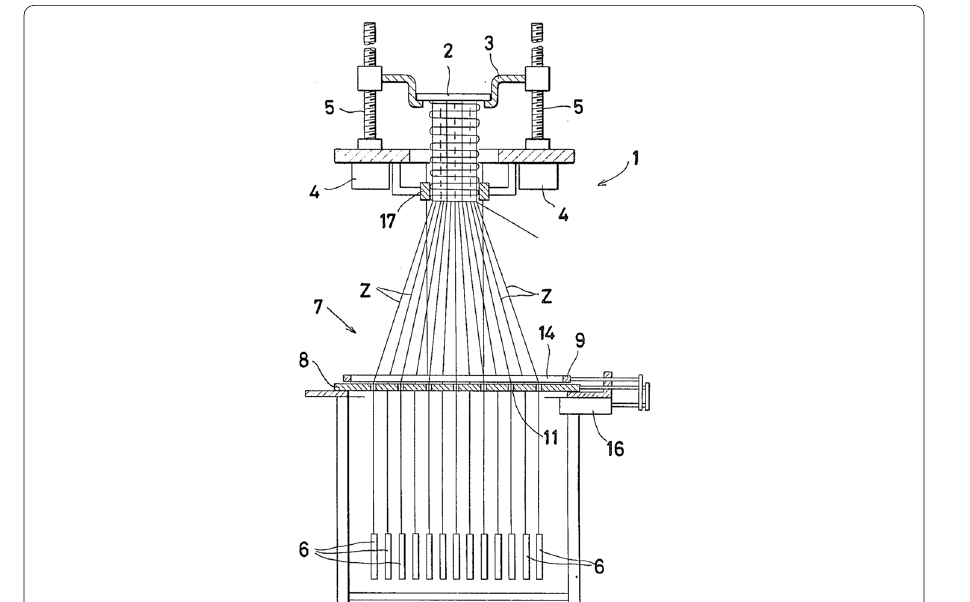
Fig. 1 Plan view of the 3D fully interlaced preform weaving device by Fukuta et al. (1982). 1—frame, 2— support plate, 3—setting frames, 4—motor, 5—screw shafts, 6—weights, 7—heald device, 8—first heald bar, 9—second heald bar, 11—holes, 14—slits, 16—drive for the second heald bar, 17—frame member